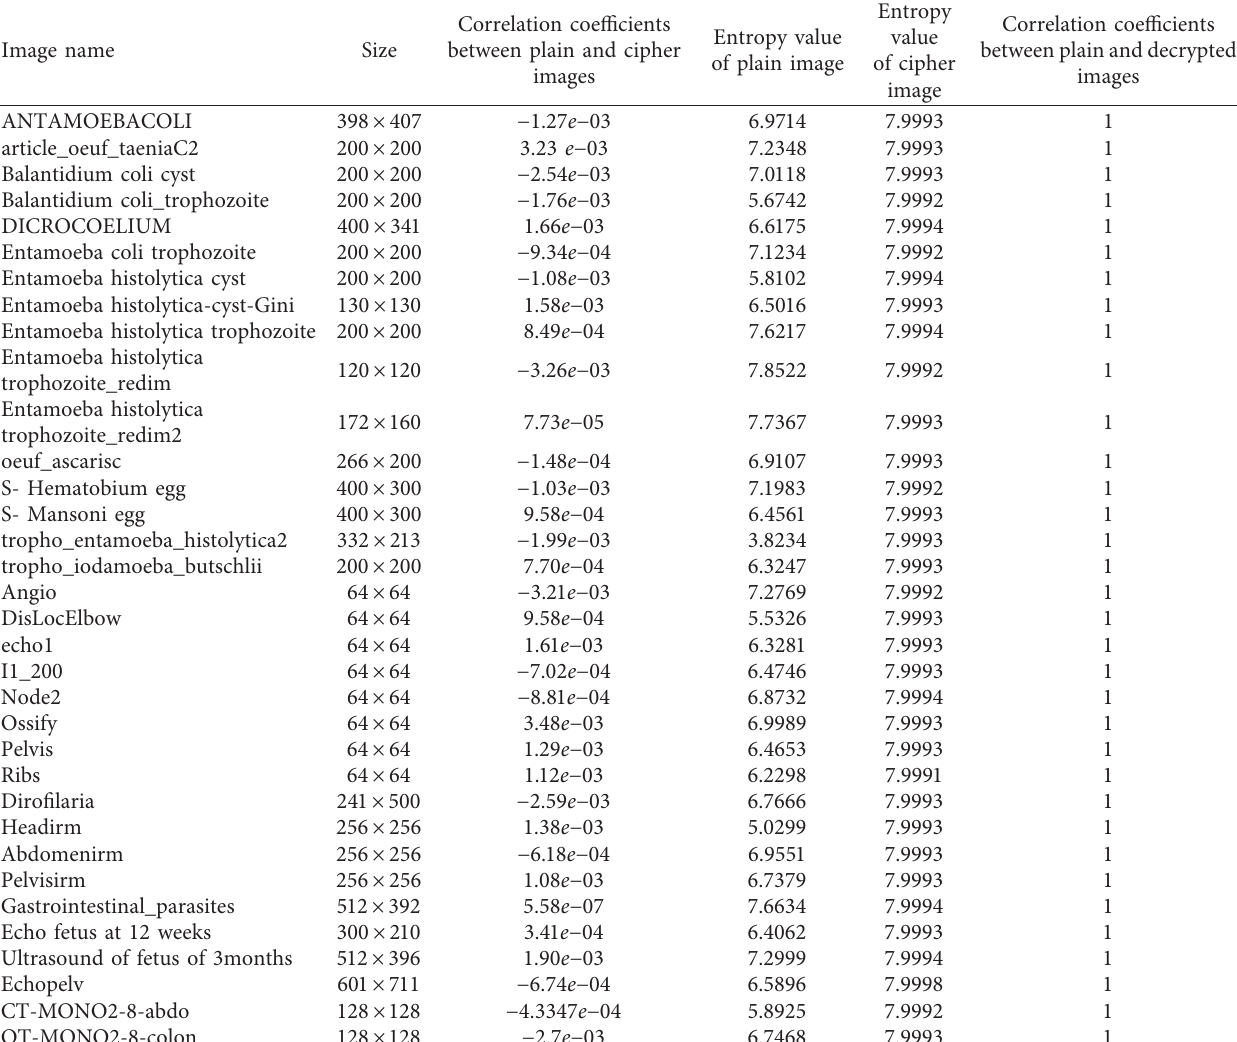
Table 3: Correlation coefficients and entropy information of some medical